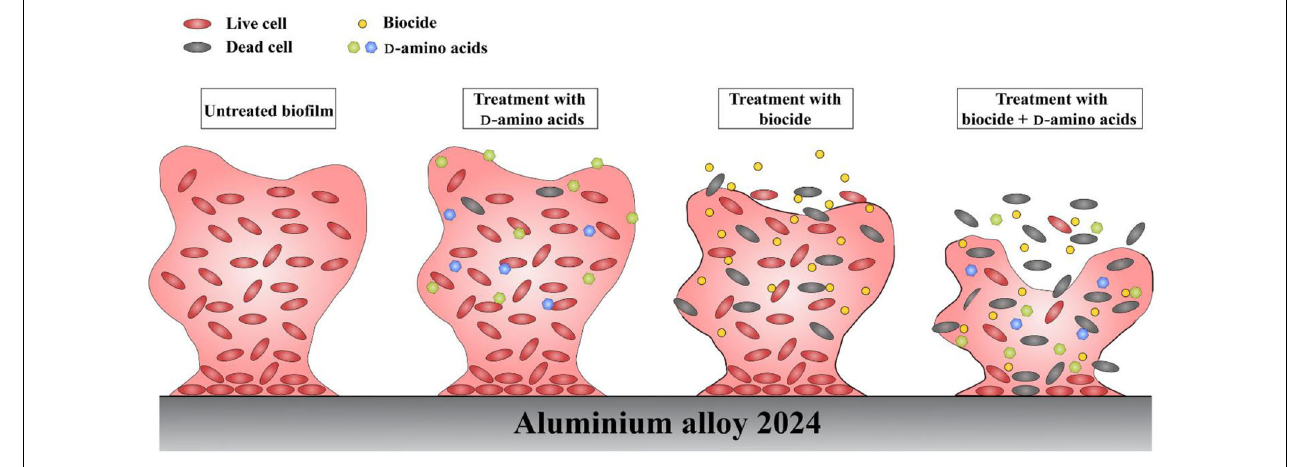
FIGURE 12 | Schematic illustration of the synergy between D -amino acids and biocide.